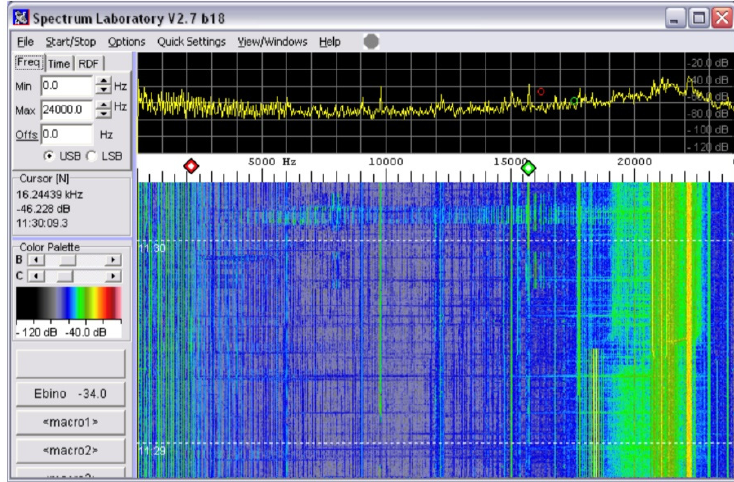
Fig 2: ‘Spectrum Lab’